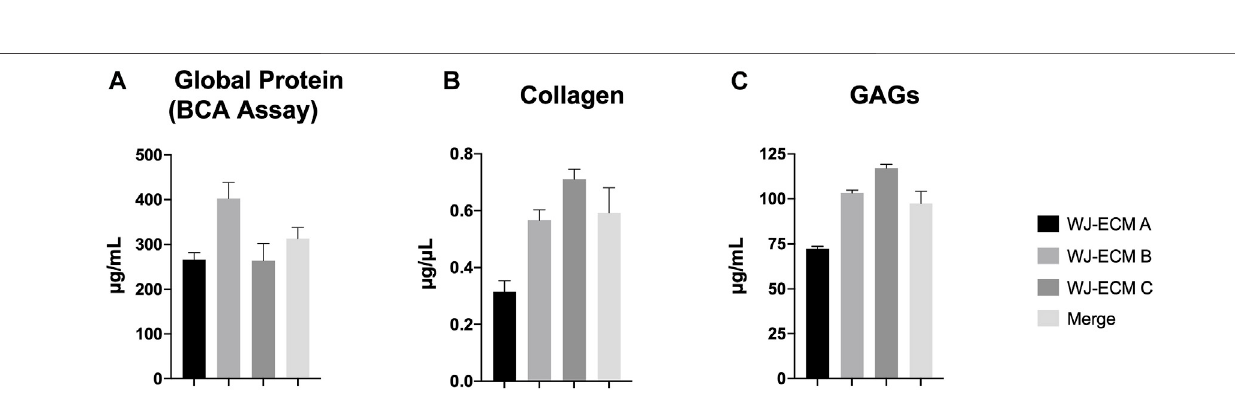
FIGURE2| Global protein, collagen and glycosaminoglycan(GAG) contentofWJ-ECMaa. (A) Proteincontentforeach pool ofWJ-ECMaa and thecorresponding meanvalues. (B) CollagencontentforeachpoolofWJ-ECMaaandthecorrespondingmeanvalue. (C) GAGcontentforeachpoolofWJ-ECMaaandthecorresponding mean value. Results are presented as the mean of the three pools of WJ-ECM ± SEM.